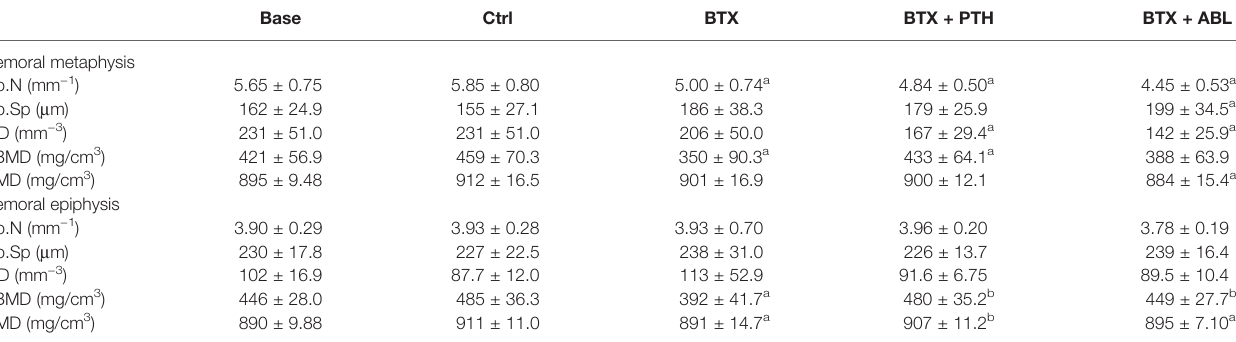
TABLE 3 | Microstructural properties of the right femoral epiphysis and metaphysis from rats with the right hindlimb immobilized with BTX and treated with PTH or ABL. Base Ctrl BTX BTX + PTH BTX + ABL Femoral metaphysis Tb.N (mm − 1